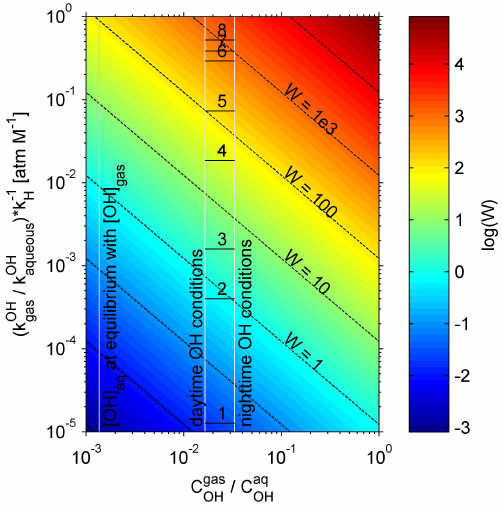
Fig. 4. The ratio of the rate of gas phase OH oxidation to the rate of Fig. 5. The ratio of the rate of gas phase OH oxidation to the rate of aqueous phase oxidation for a series of peroxides and ethers in an aqueous phase oxidation for a series of carbonyls in an air parcel air parcel with a liquid water content of 0.5gm − 3 at 298K. Labeled with a liquid water content of 0.5gm − 3 at 298K. Labeled hor- (defined / C aqueous horizontal lines are bound by differences in C gas (defined / C aqueous izontal lines are bound by differences in C gas OH OH OH OH as the moles of OH per volume of air/the moles of OH per volume as the moles of OH per volume of air/the moles of OH per vol- of liquid) during different times of the day. The line demarcating ume of liquid) during different times of the day. The line demar- OH at Henry’s law equilibrium is shown on the left side of the plot. cating OH at Henry’s law equilibrium is shown on the left side of Species are labeled in order of increasing W : (1) hydrogen peroxide, the plot. Species are labeled in order of increasing W : (1) glyoxal, (2) ethyl peroxide, (3) methyl peroxide, (4) methyl tert-butyl ether, (2) methyl glyoxal, (3) formaldehyde, (4) acetone, (5) 2-butanone, (5) dimethyl ether, and (6) ethyl ether. (6) acetaldehyde, (7) butanal, and (8) propanal.